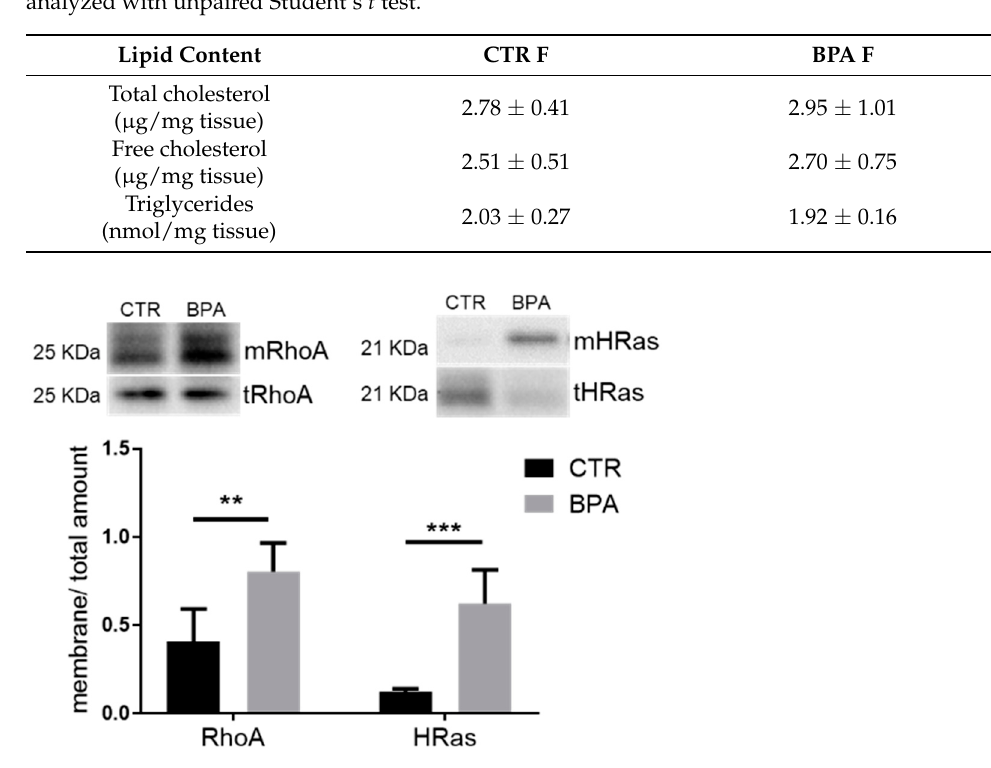
Figure 6. Effects of prenatal exposition to 2.5 µ g/kg/day of BPA on RhoA and HRas prenylation in fetal livers of female rats. The figure shows typical Western blot of membrane-bound RhoA (mRhoA) and HRas (mHRas), and their total content in the lysate of female fetus livers from CTR animals and the ones prenatally exposed to BPA. The graph represents the ratio of membrane-bound and total levels of the proteins in liver lysates. Values are expressed as mean ± SD, n = 6 for each experimental group. Differences between groups were considered as significant at p < 0.05 and were analyzed